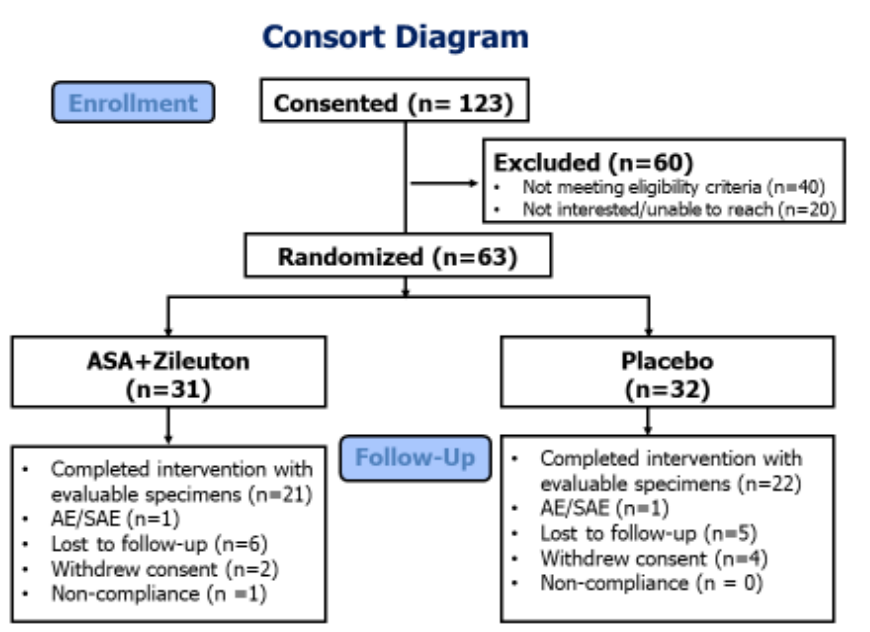
Figure 1. Consort flow diagram.